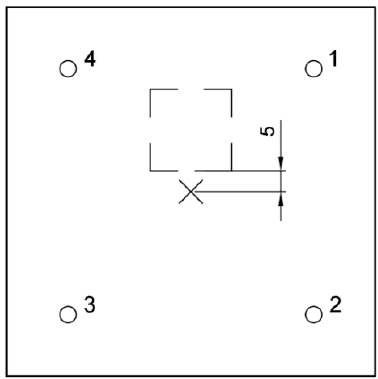
Figure 13. Scheme of void and IE device layout, edge 5 cm from impactor.